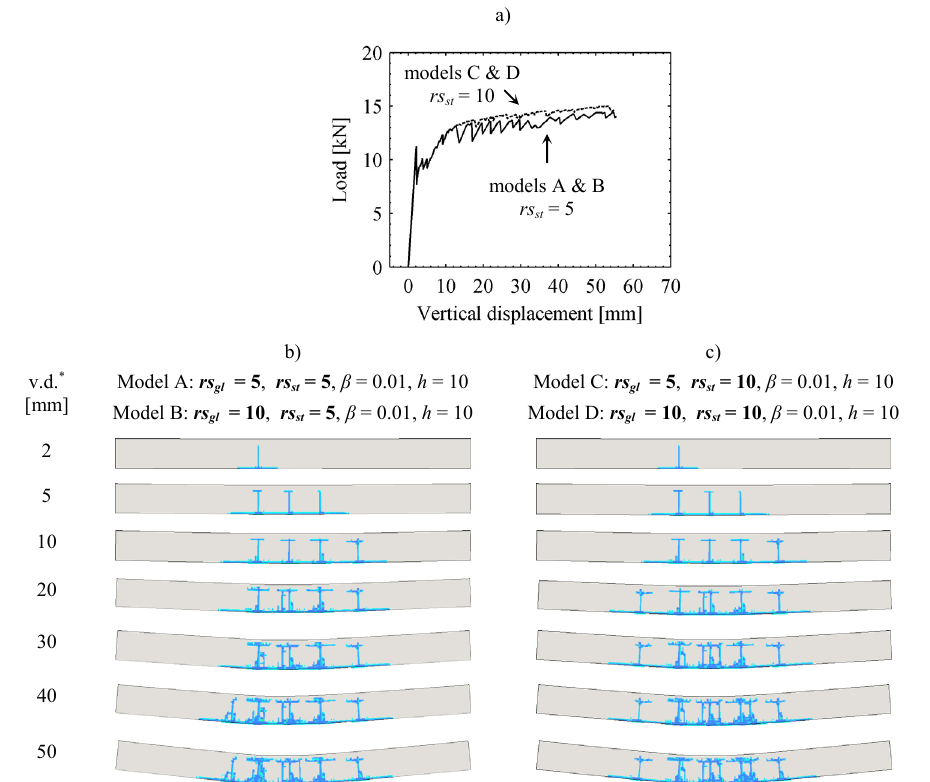
Figure 7: a) Load-displacement diagrams of models A, B, C and D with varying reduction steps; b) contour plot of the reduced E-moduli (crack pattern) of model A and B; c) contour plot of the reduced E-moduli (crack pattern) of model C and D; * v.d. = vertical